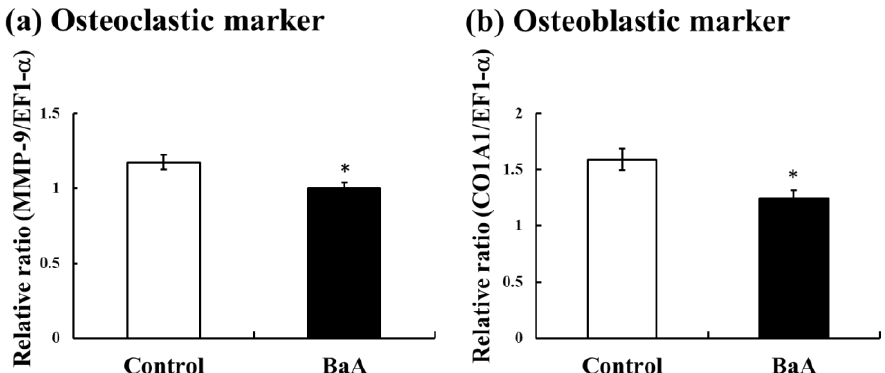
Figure 2. Effects of BaA on osteoclastic (a) and osteoblastic (b) marker messengerRNA (mRNA) expression in the scales of BaA-treated or untreated nibbler fish. BaA (10 ng/g body weight) was injected intraperitoneally (four times) into nibbler fish for 10 days during breeding. Thereafter, osteoclastic and osteoblastic marker mRNA expressions were examined in the control and experimental groups. * indicates a statistically significant difference at p < 0.05 from the values in the control scales (n = 8).